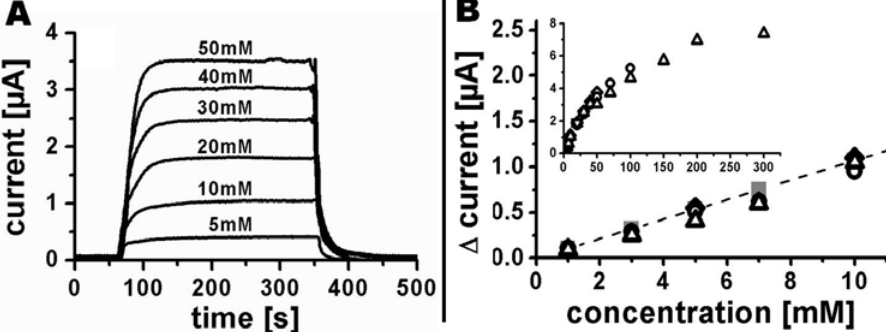
Figure 7. ( A ) Amperometric response of a ten Ø 100 μ m tubular PEDOT electrode array to different potassium ferrocyanide concentrations in 0.1 M potassium phosphate buffer, at a flow rate of 100 μ L/min and an electrode polarization of 500 mV vs. Ag|AgCl|3M NaCl; ( B ) Current change versus potassium ferrocyanide concentration for the linear response regime in the range from 1 to 10 mM. Insert: Current change for all analyzed potassium ferrocyanide concentrations. Different black, open symbols represent measurements with independent systems, closed gray squares connected with the dashed line are the results predicted by finite element